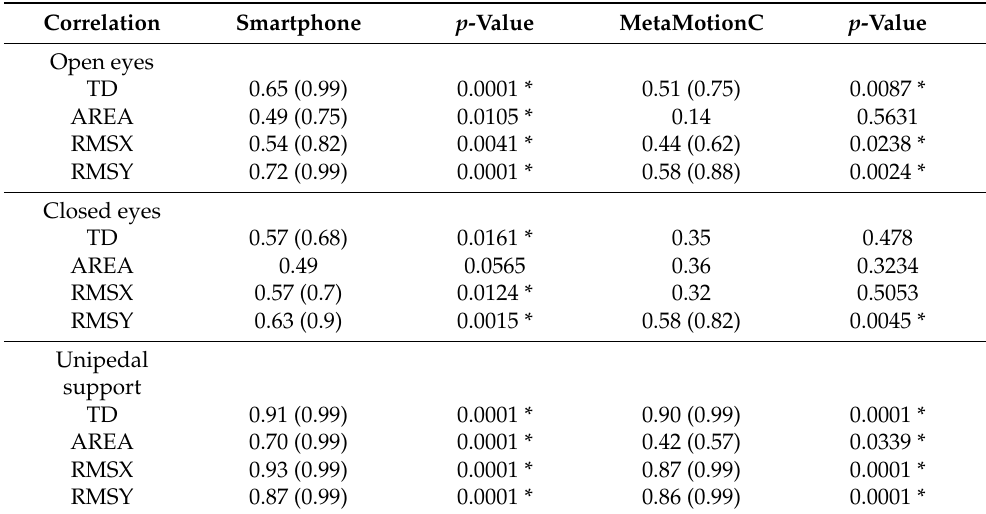
Table 3. Pearson’s correlation results between the force platform and the inertial sensors of smart- phones and wearable devices. In the significant correlations, the two-sided power analysis is shown inside the